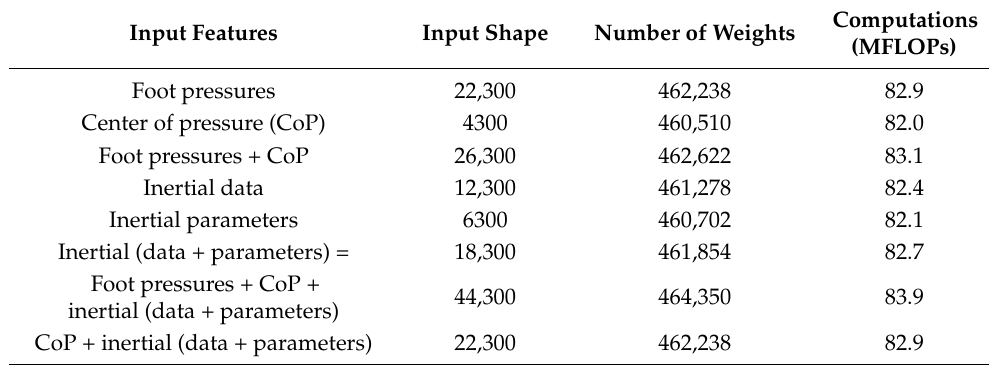
Table 9. Computational complexity of the deep neural